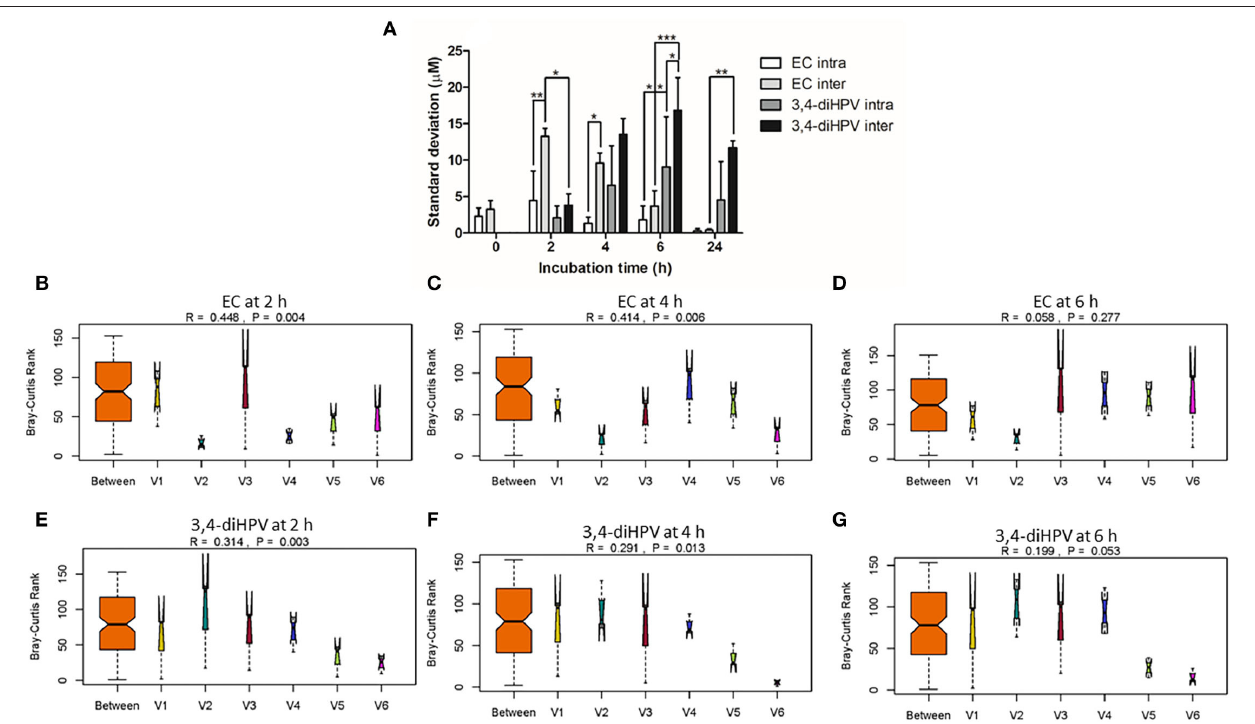
FIGURE 3 | Standard deviations (SDs) that represent intra- and inter-individual differences in EC depletion and 3,4-diHPV formation among six individuals over three collecting weeks (A) . Two-way ANOVA with Bonferroni multiple comparisons were performed to evaluate intra- and inter-individual differences in EC depletion and 3,4-diHPV formation. Statistical differences between different treatments are demonstrated (* P < 0.05; **0.001 < P < 0.01; *** P < 0.001) (A) . Analysis of similarities (ANOSIM) test on results of EC depletion and 3,4-diHPV formation at 2, 4, and 6h of incubations (B–G) ; (B–D) and (E–G) are results of EC depletion and 3,4-diHPV formation at 2, 4, and 6h, respectively). R > 0 indicates differences between groups are larger than within the group. V1–6: individuals 1–6.